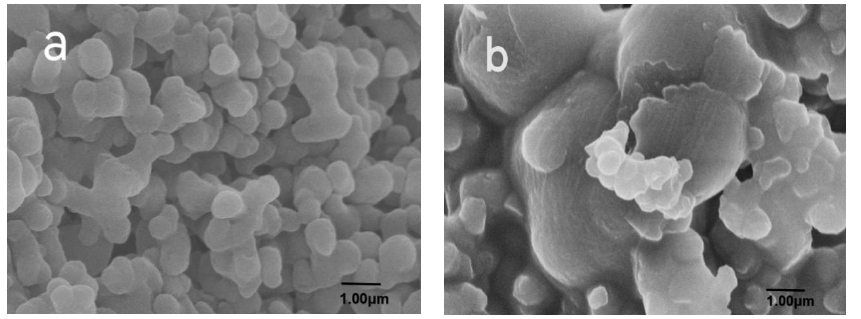
Figure 3. The SEM image of ( a ) blank RC-nZVI and ( b ) RC-nZVI after reaction with Cr(VI) = 5.1 mg L − 1 .